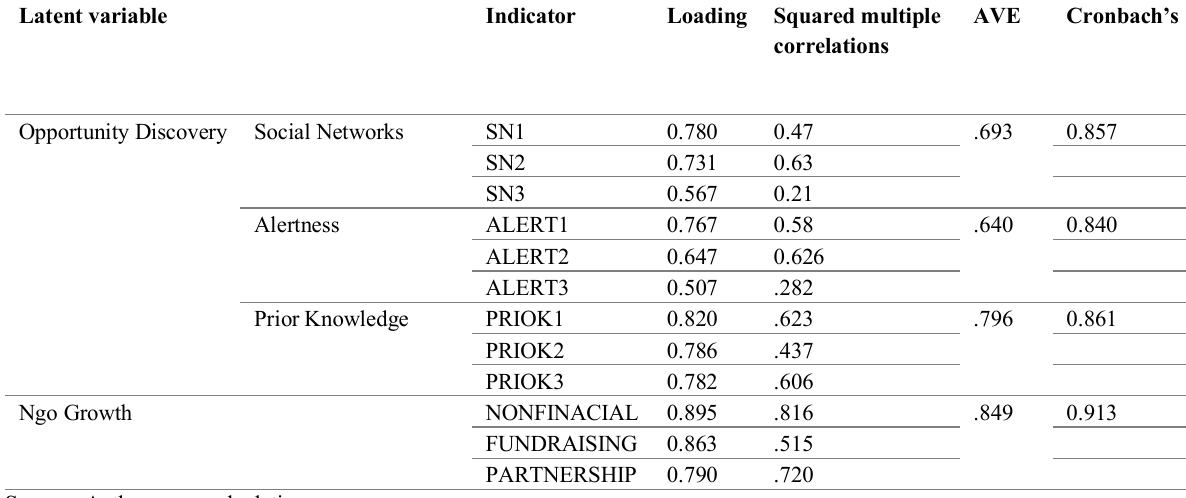
Table 2: Measurement model summary of entrepreneurial opportunity discovery dimensions Latent